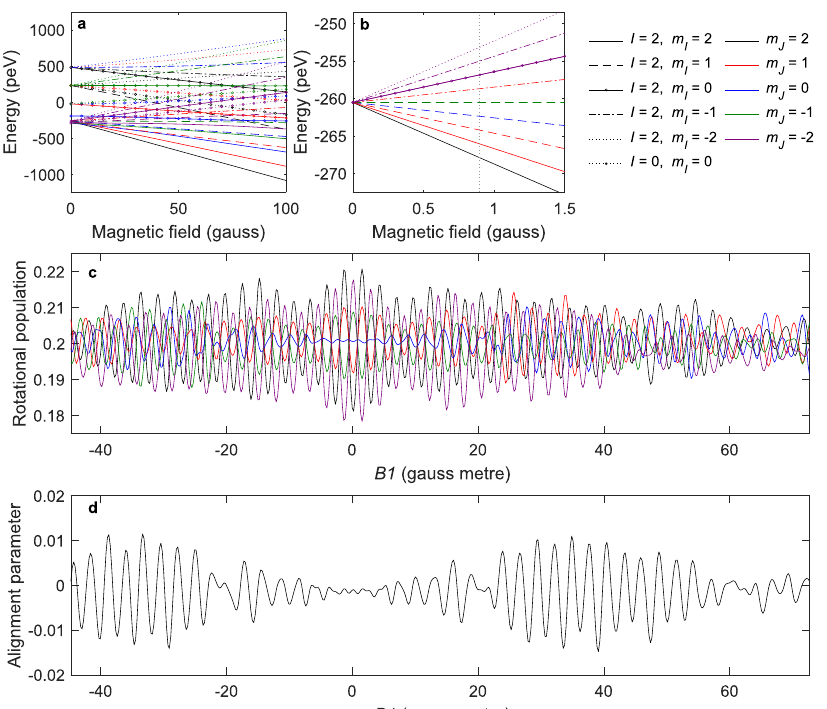
Fig. 3 Manipulation of the m I , m J states of the J = 2 rotational level of D 2 in magnetic fi elds. a Magnetic fi eld dependence of the energy of the 30 m I , m J states for D 2 in the J = 2 state. The legend speci fi es the colour scheme used, where different types of lines were used to distinguish different I and m I combinations, and the colours identify the m J projection state. b Magni fi cation of a showing the energy of some of the states in low magnetic fi eld. c Calculated populations in the m J states of the J = 2 D 2 molecules that collide with the surface. The quantisation axis is the surface normal, and the colour scheme for the m J populations follows that of a and b . d The alignment parameter of the impinging molecules. Source data are provided as a Source Data fi